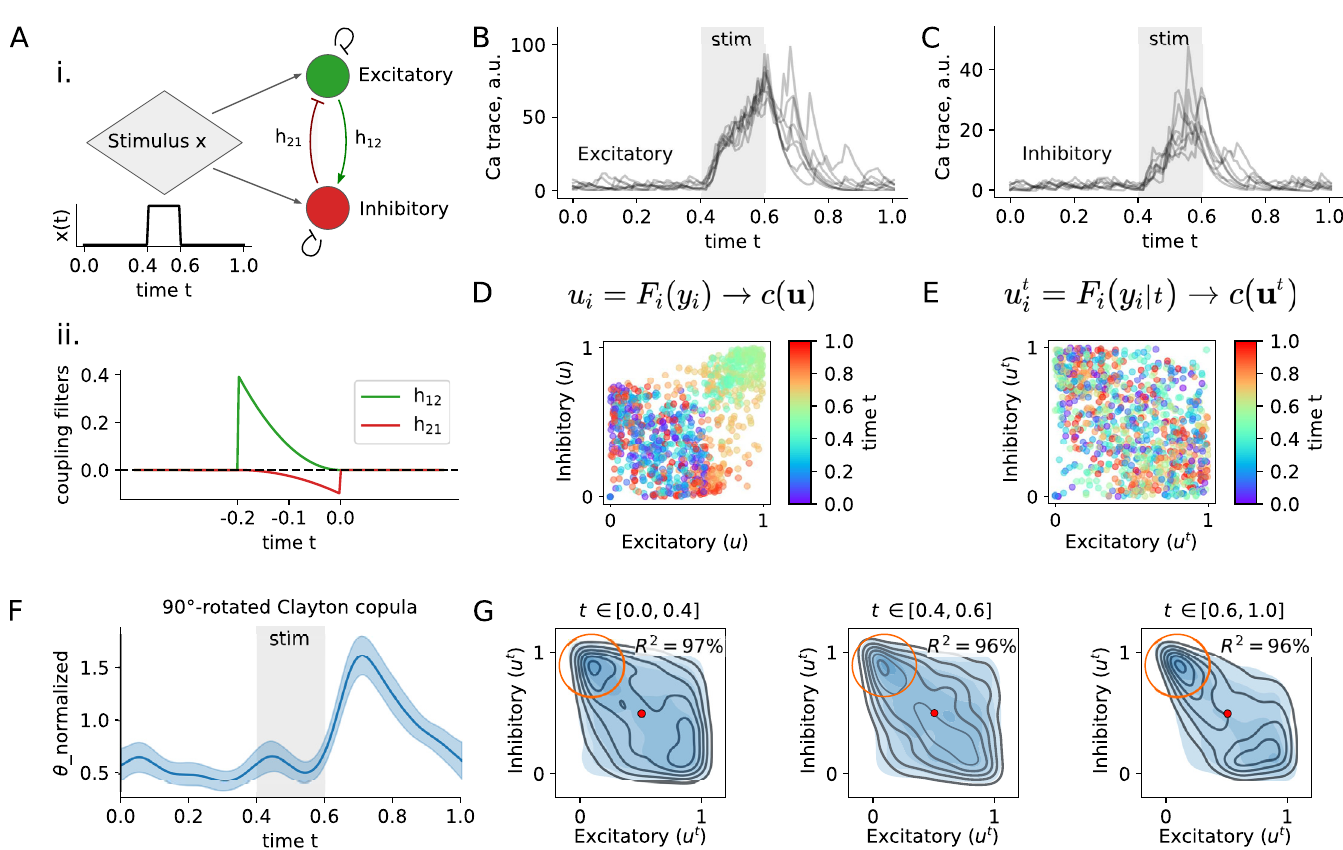
Fig 3. Copula-GP describes the noise correlations between dynamically coupled neurons with a Clayton copula. A i. GLM model of two coupled neurons (excitatory and inhibitory) that receive the same time-dependent input x ( t ); ii. the spike history coupling filters h 12 and h 21 ; B-C simulated calcium transients (fluorescence across time) showing dynamic responses to the stimulus x ( t ) for excitatory and inhibitory neurons, respectively; D calcium transients of two neurons ( y 1 ( t ), y 2 ( t )) projected onto a unit cube by the probability integral transform based on unconditional marginals; colored points show transformed samples ( u 1 , u 2 ) corresponding to times t (color-coded). The clusters of similarly colored points (e.g. green) illustrate that the copula c ( u ) depends on time t ; the particular shape and the location of the clusters depends on the function x ( t ). E same as D, but based on conditional marginals F ( y | t ). The resulting copula describes ‘noise correlations’ between two neurons. The i i colored data-points ( u t , u t ) are not uniformly distributed on the unit square, which suggests that the noise correlation between these neurons and the copula c ( u t ) itself 1 2 depends on time t . F Clayton copula parameter ( θ ) that characterizes the strength of the non-linear noise correlation between neurons (see Methods for details); G probability density plots illustrating the stimulus-dependent shape of noise correlations. The empirical dependence estimated from data samples is shown with black outlines, while the predictions of the Clayton copula model are shown in shades of blue. The proportion of the variance explained R 2 is indicated in the upper-right corner for each time interval. Orange circles indicate the heavy tail of the distribution, which can be best seen in the range t 2 [0.6, 1.0] where the variables are stronger